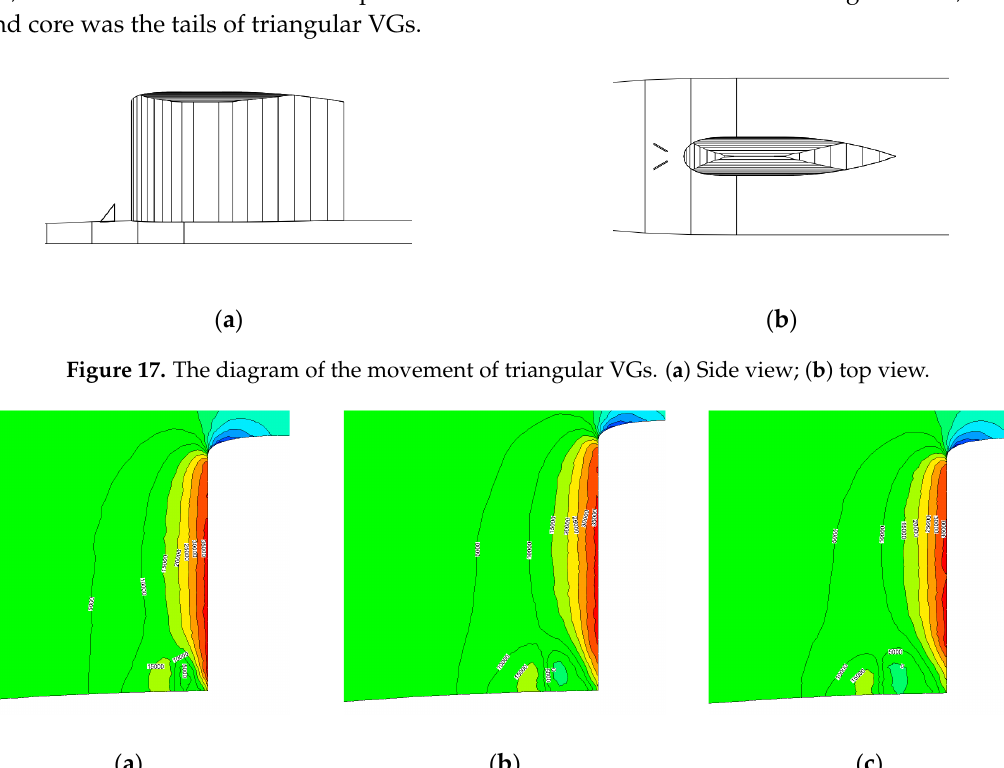
( d ) Figure 19. The streamline of Plane B between the original model and the model with triangular VGs at different distances. ( a ) The original model; ( b ) VGs at 0.1c; ( c ) VGs at 0.15c; ( d ) VGs at 0.2c.